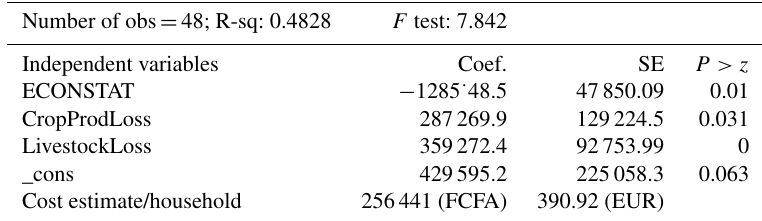
Table 11. Costs of floods – multivariate linear regression model.